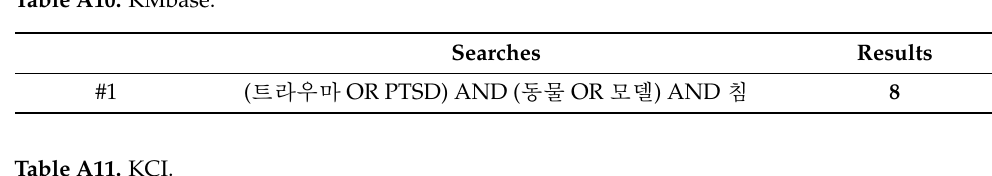
Table A10. KMbase.